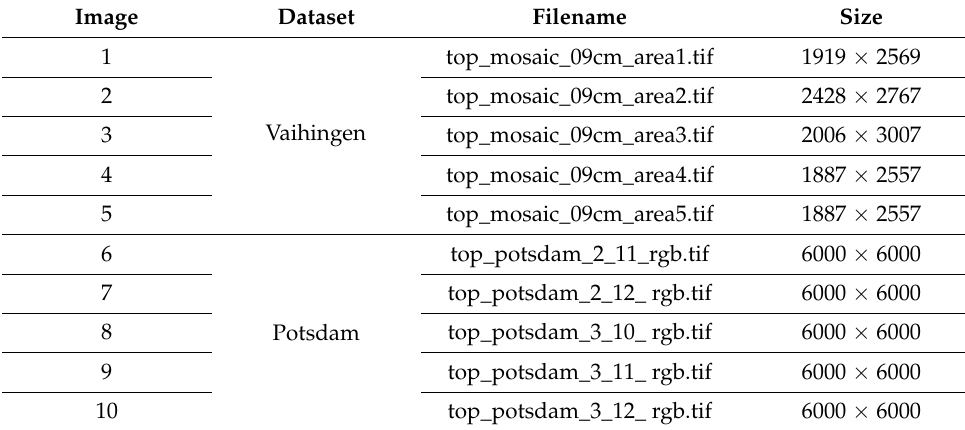
Table 6. Details of additional remote sensing test images.